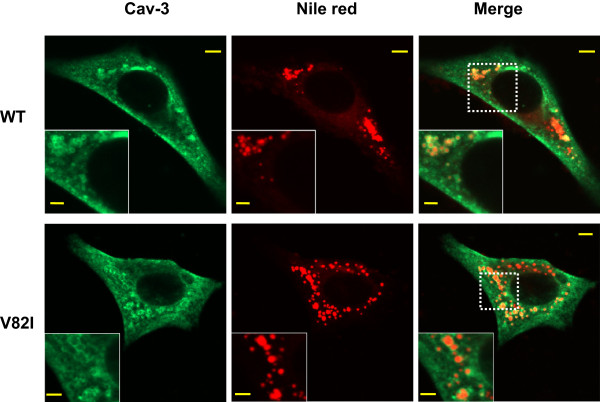
Colocalization analysis of Cav-3 WT and Cav-3 V82I with the LB marker Nile red. Cav-3 transfected cells were labeled with Cav-3 antibodies followed by Alexa Fluor 488 conjugated secondary antibodies. LBs were then stained with Nile red (1:100 dilution in PBS from 1 mg/ml stock solution in acetone). BHK cells expressing Cav-3 V82I (bottom) showed a marked localization in LB structures (bottom) as compared to Cav-3 WT (top). Scale bar: 5 μm (2.5 μm in the inserts). Two independent transfected cultures were analyzed.